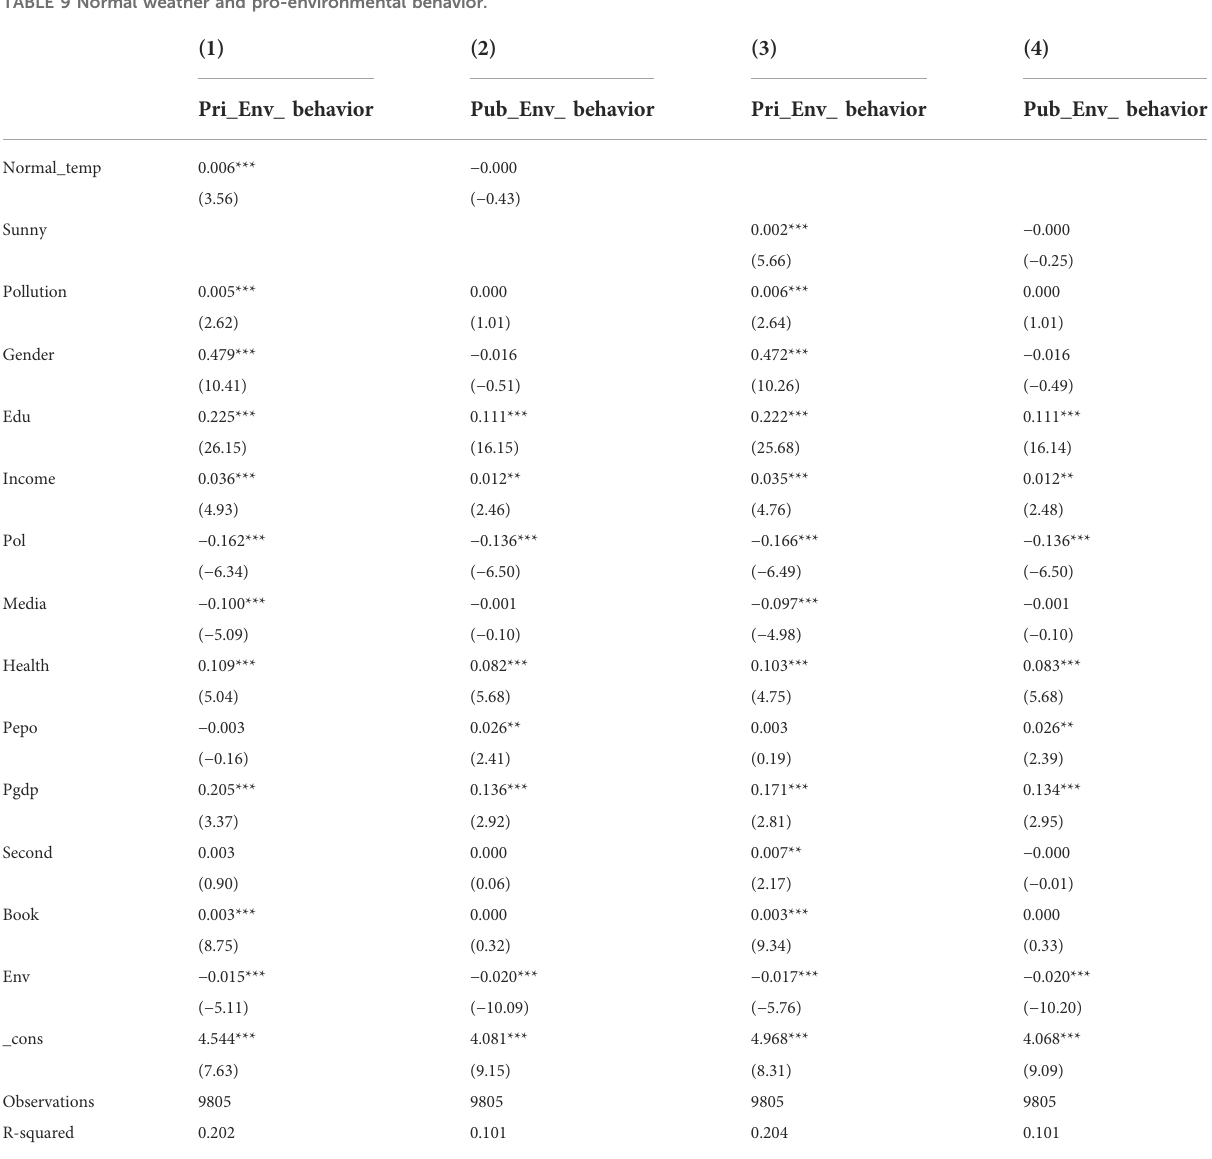
TABLE 9 Normal weather and pro-environmental